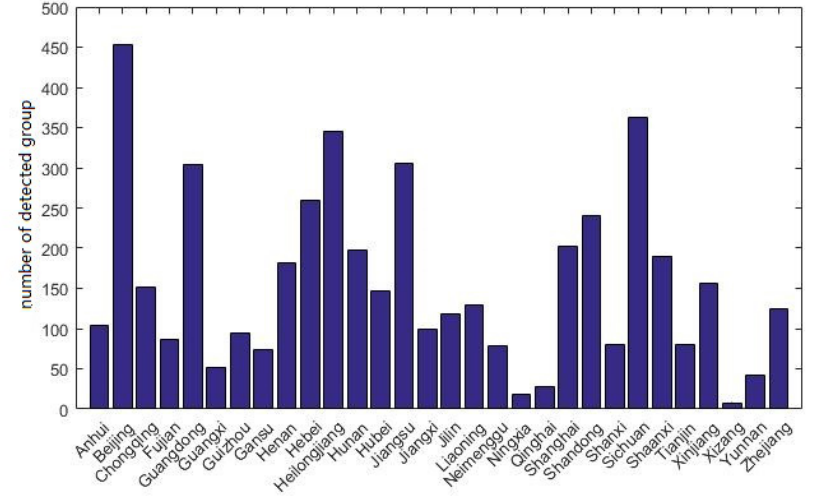
Figure 8. Geographical distribution of group tourists, X -axis is provinces, Y -axis is the number of detected group from each